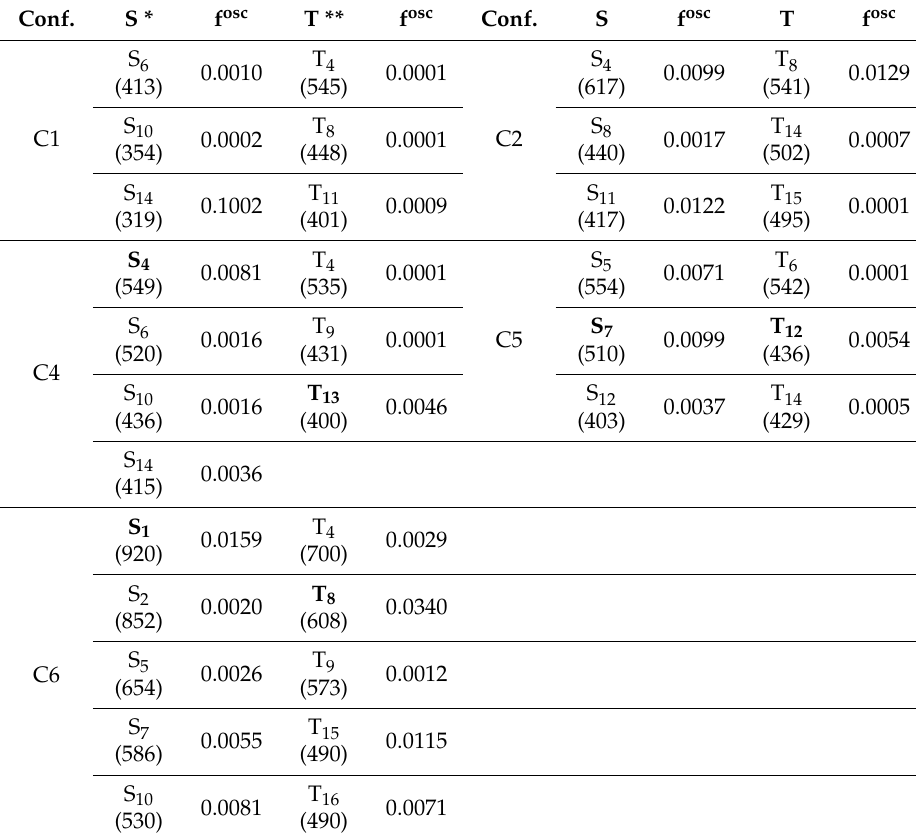
Table 2. The most relevant electronic excited states (wavenumber given in parenthesis in nm) and their oscillator strength (f osc ) of the five proposed metal-organic complexes (C1, C2, C4–C6) obtained at TD-DFT / M06 / def2-TZVP level of theory, both with singlet (S) and triplet (T) spin configuration. Conf. S * f osc T ** f osc Conf. S f osc